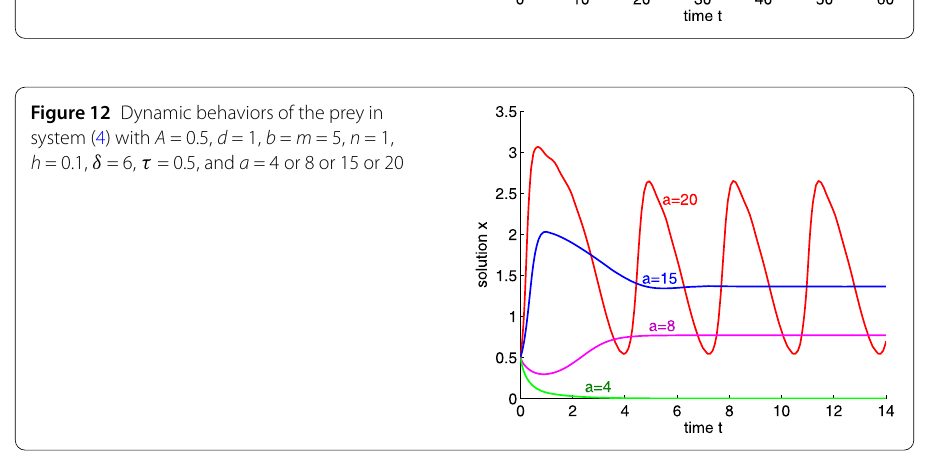
Figure 13 Dynamic behaviors of the predator in system (4) with A = 0.5, d = 1, b = m = 5, n = 1, h = 0.1, δ = 6, τ = 0.5, and a = 4 or 8 or 15 or